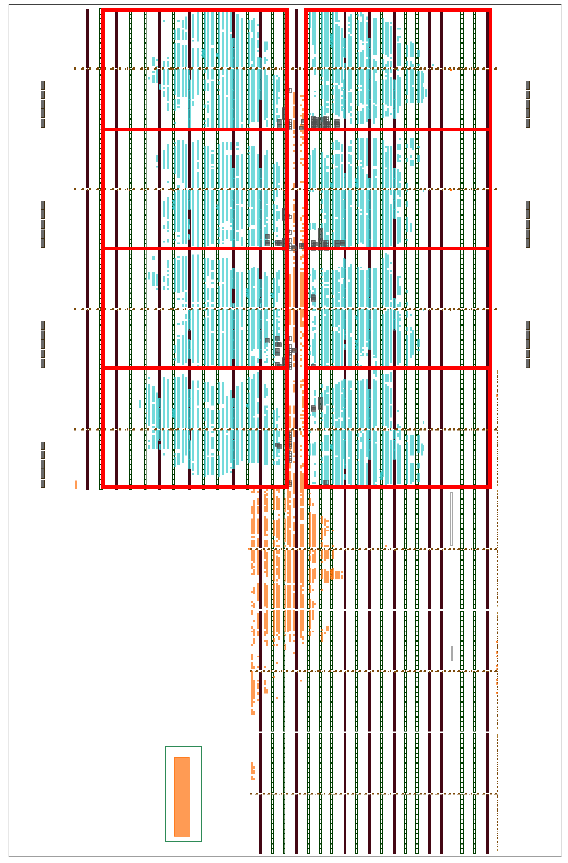
Figure 7. Layout of the implemented system on the ZCU102 development board.